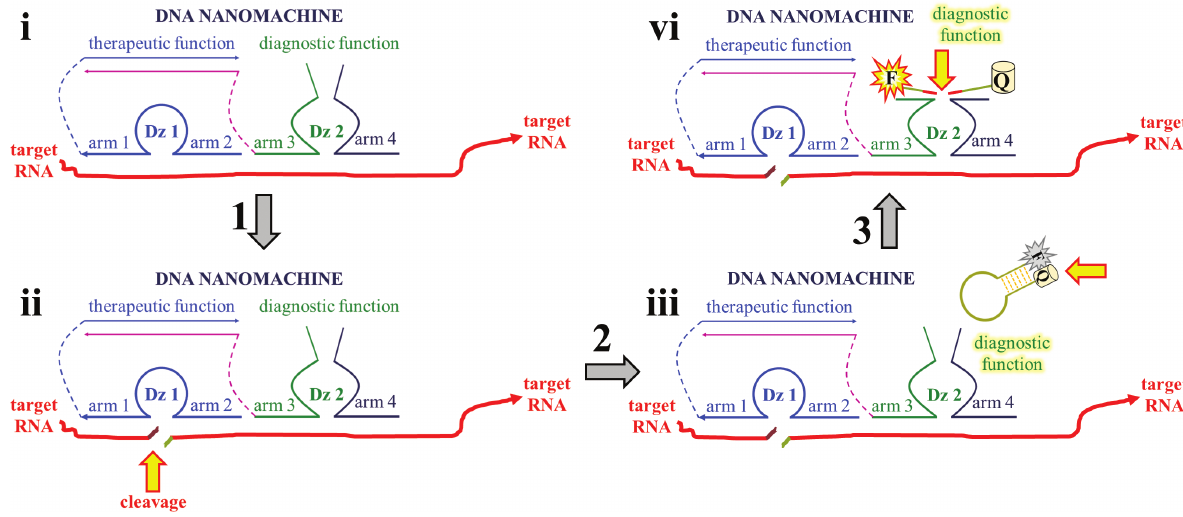
Figure 4. Design of the theranostic nanomachine for targeting and cleavage of RNA. Reaction 1 : the nanomachine strand with Dz1 catalytic core (deoxyribozyme) bind to a specific site of the target RNA by Watson-Crick base pairing and cleave the chain. Reaction 2 : a binary sensor hybridizes in complementary approach to form Dz2 core, which is able to react with a fluorescent reporter. Reac- tion 3 : Dz2 core cleaves the fluorescent reporter and induces a fluorescent signal with increased